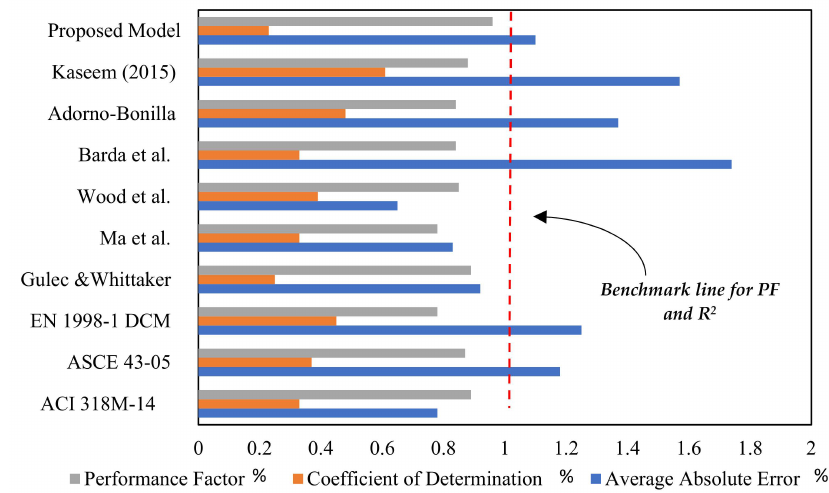
Figure 8. Comparison of previously proposed models based on statistical